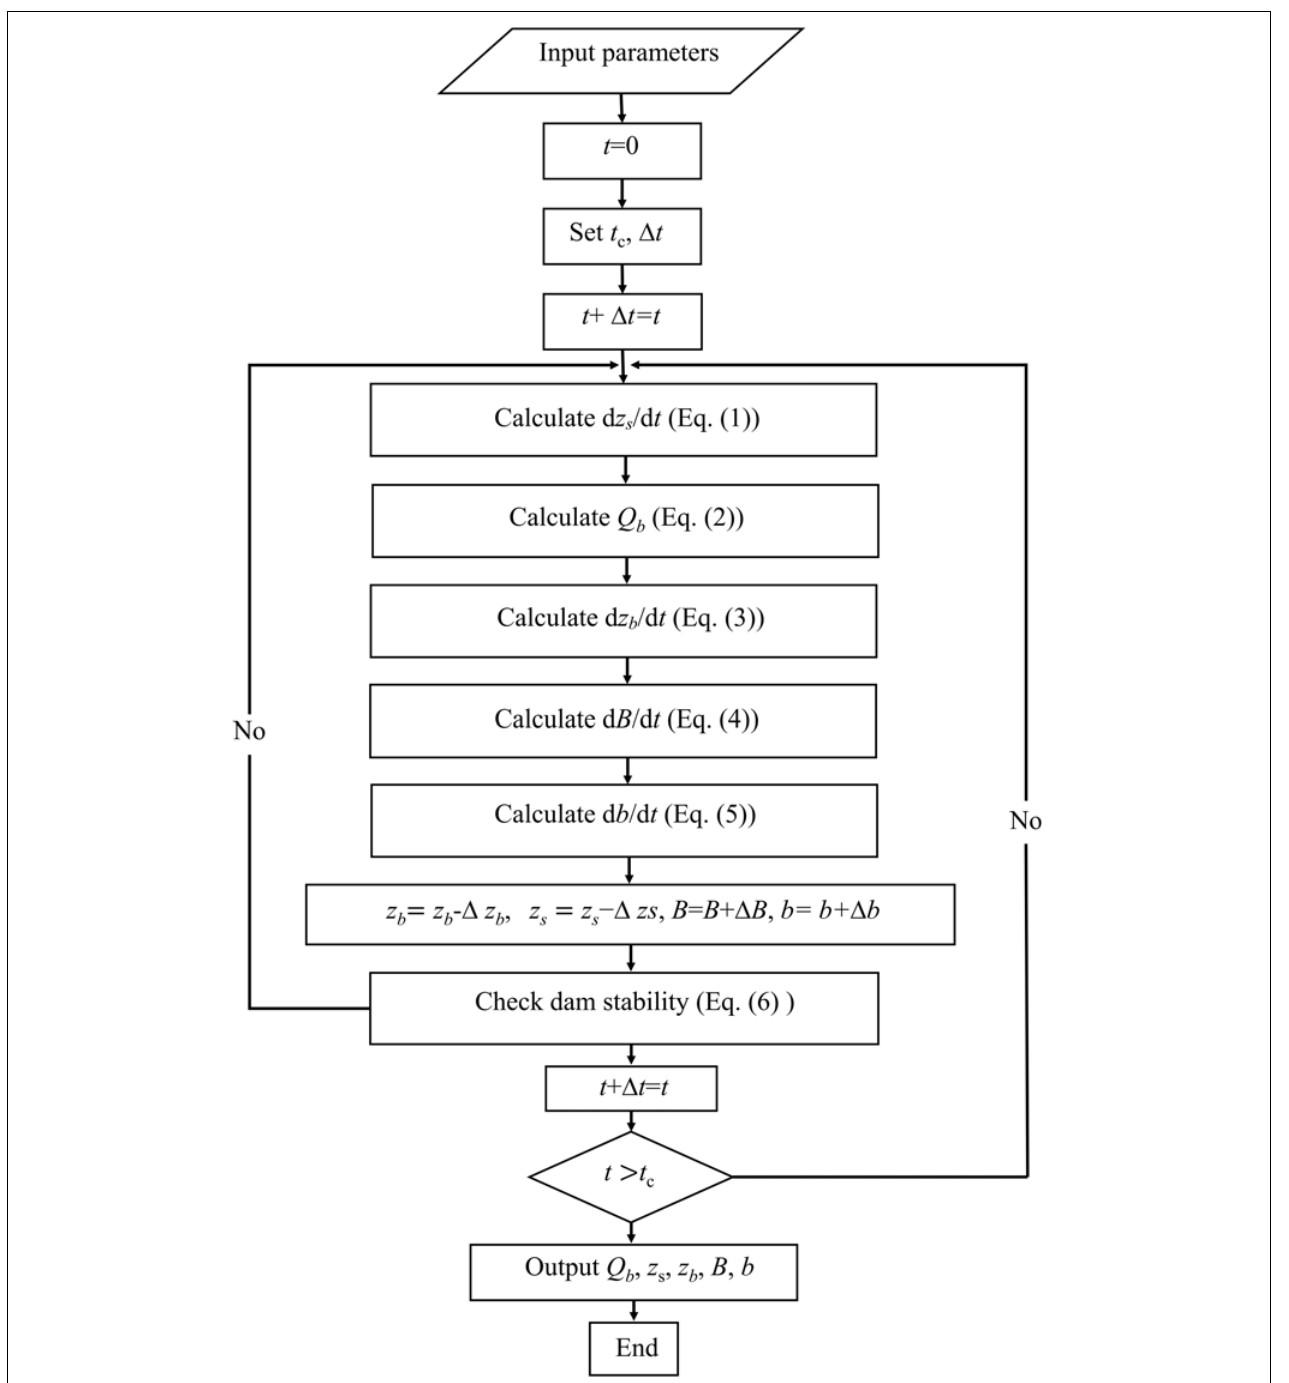
FIGURE 8 | Flow chart of the numerical